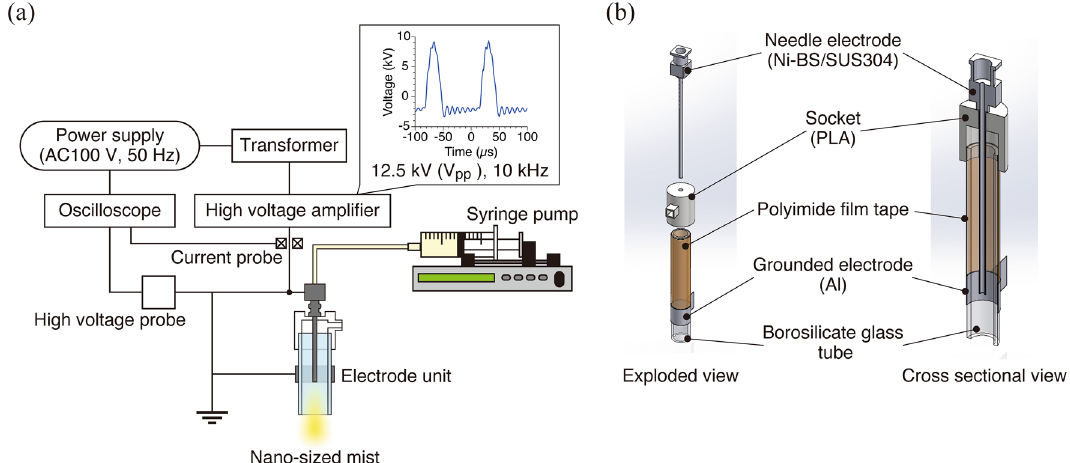
Figure 1. Nano-sized mist generator using DBD. ( a ) Configuration of the generator. ( b ) Electrode